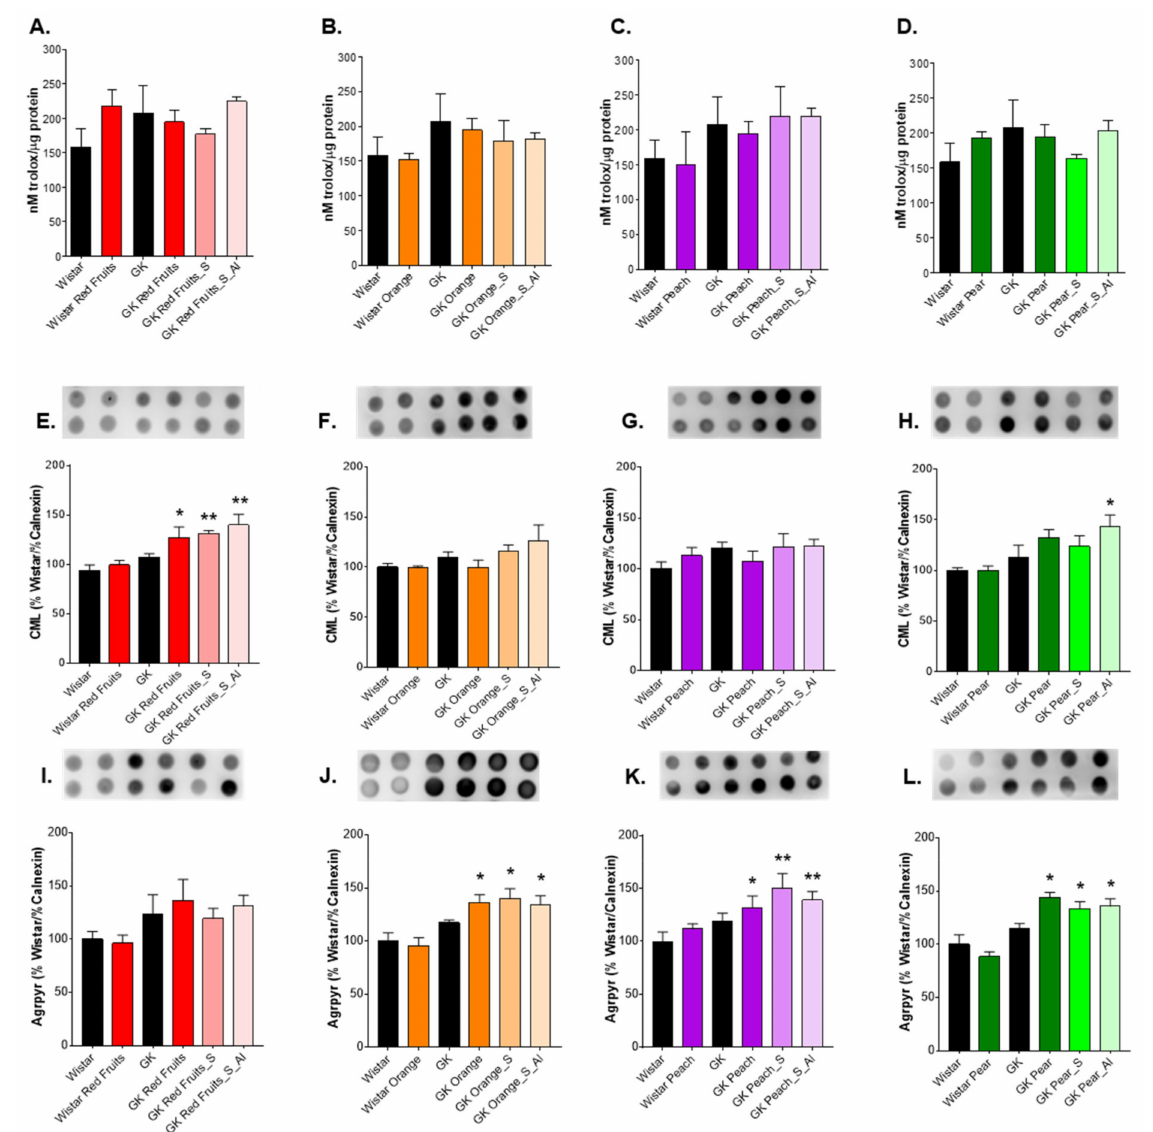
Figure 4. In isolated erythrocytes, total antioxidant capacity was determined ( A – D ) and CML ( E – H ) and argpyrimidine ( I – L ) were detected by dot blot. * different from Wistar. 1 symbol, p < 0.05; 2 symbols, p <